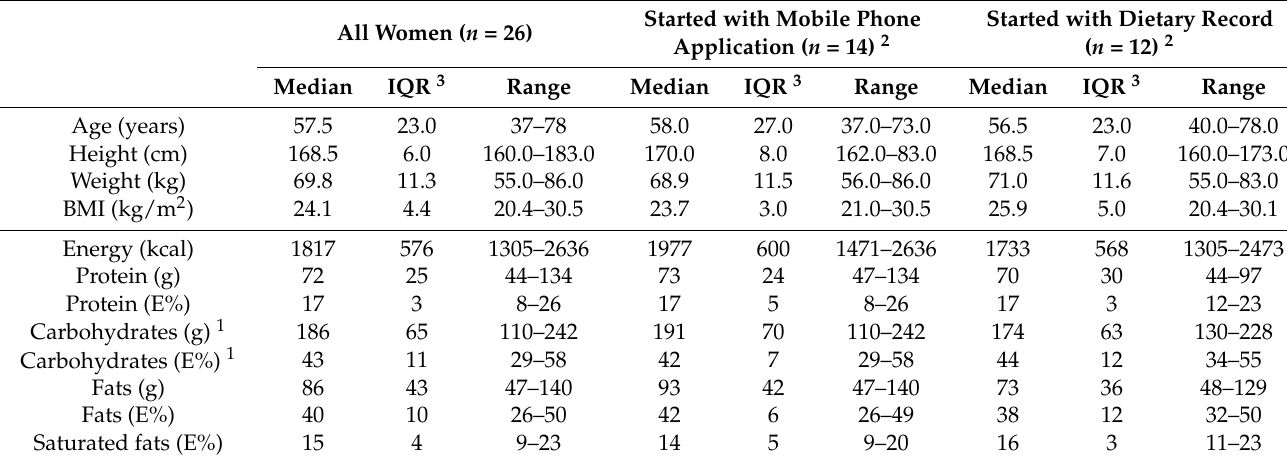
Table 1. Baseline characteristics, daily energy- and nutrient intake, and energy distribution (E %) reported from the dietary records presented for all women and separately for the two randomized groups.